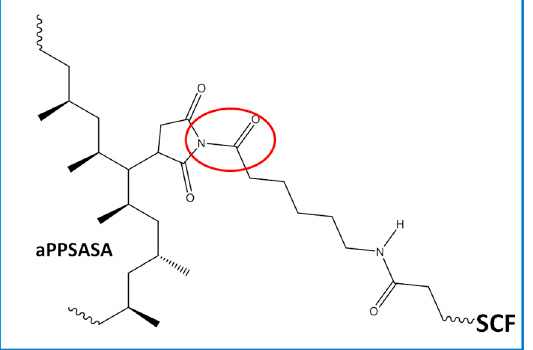
Figure 3. The chemical structure resulting from the reaction between NH 2 groups of the SFC sizing and the succinic groups of the aPP-SASA.